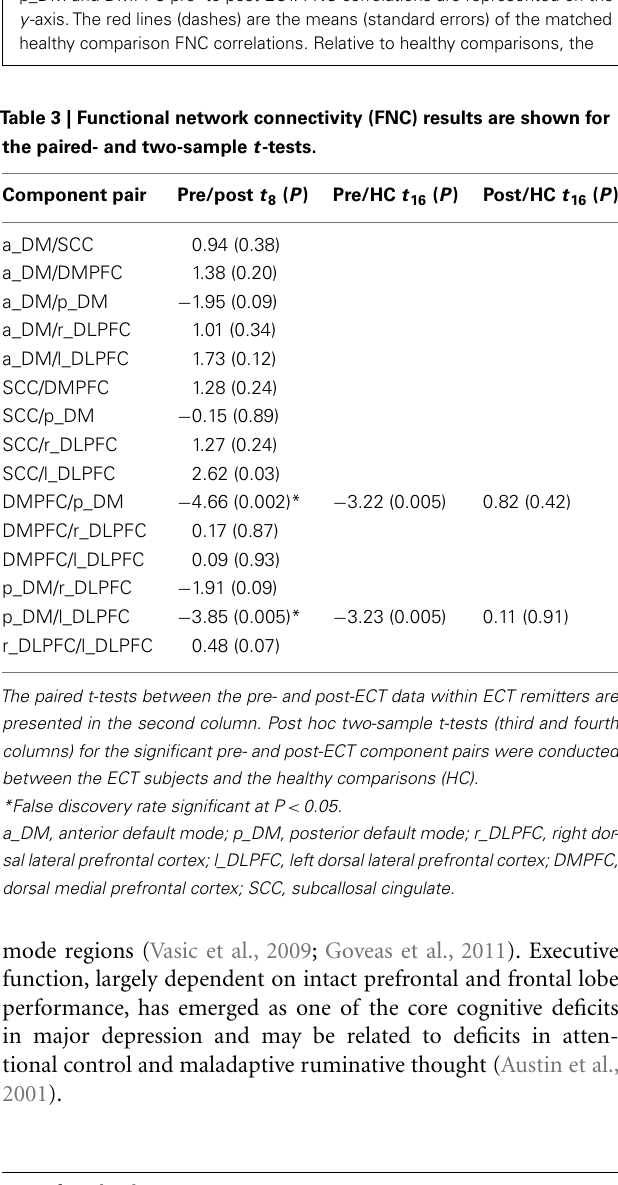
pre-ECT FNC was significantly reduced and normalized with ECT response. (B) The p_DM and l_DLPFC had a similar increase in FNC associated with the